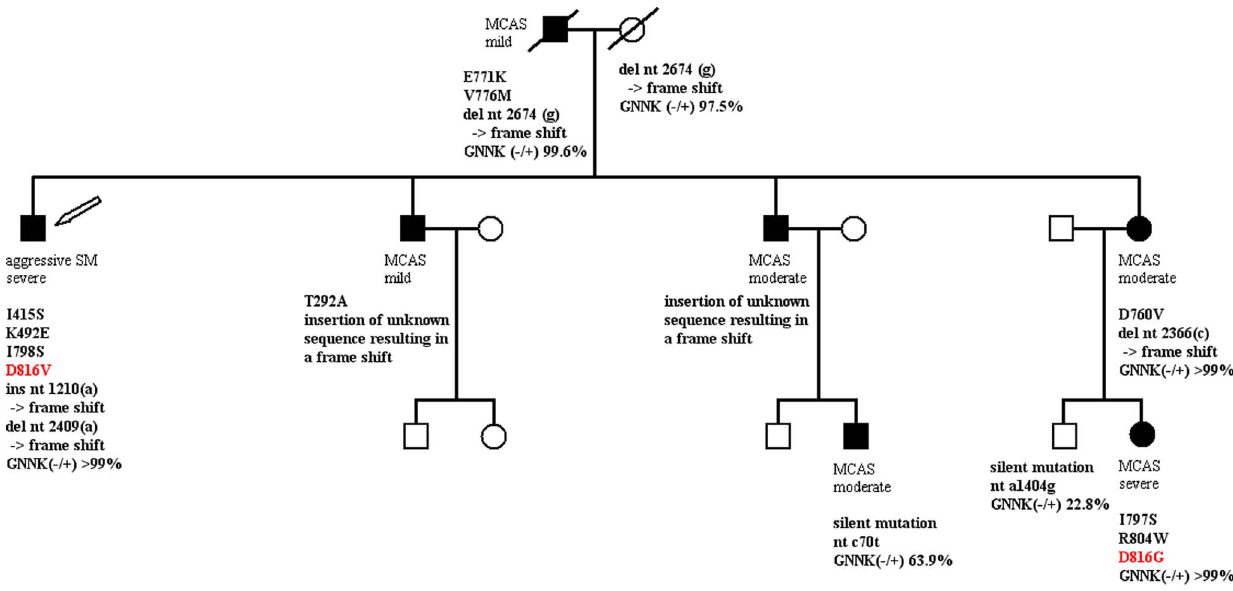
Figure 1. Pedigree of a family with a high familial loading of mast cell activation disease. Filled symbols indicate family members with either systemic mastocytosis ( SM ), according to WHO criteria, or mast cell activation syndrome ( MCAS ); open symbols denote clinically healthy family members. Squares, males; circles, females; symbols with a diagonal line through, deceased. Mild , moderate and severe indicate the clinical intensity of the mast cell activation disease. The arrow indicates the index patient. Bold type: genetic alterations detected in the tyrosine kinase, KIT . GNNK(–/ + ): ratio of the GNNK(–) over the GNNK( + ) isoform (i.e., the amount of PCR amplification product without and with the tetrapeptide sequence glycine- asparagine-asparagine-lysine